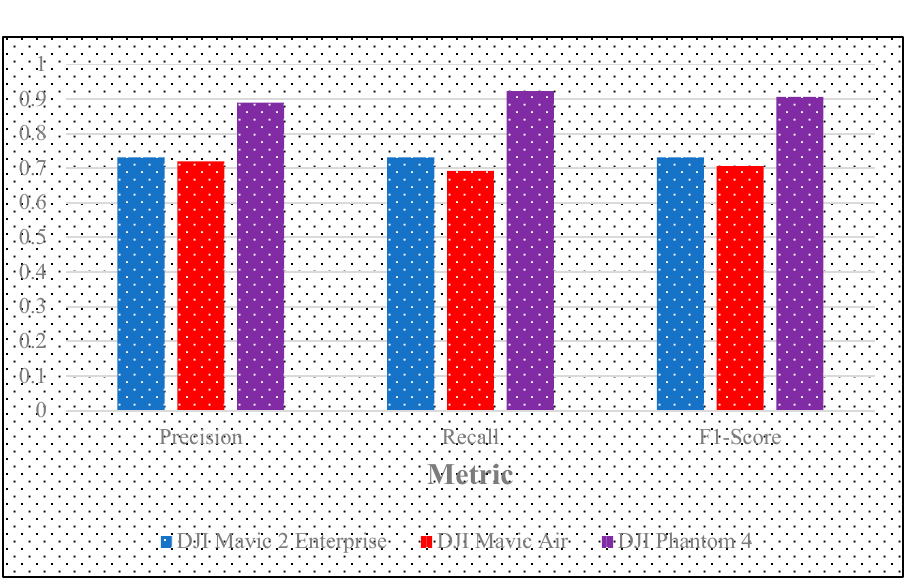
Figure 6. Per Class Metrics for Prediction of Test Images Using Trained Resnet-18 Model.